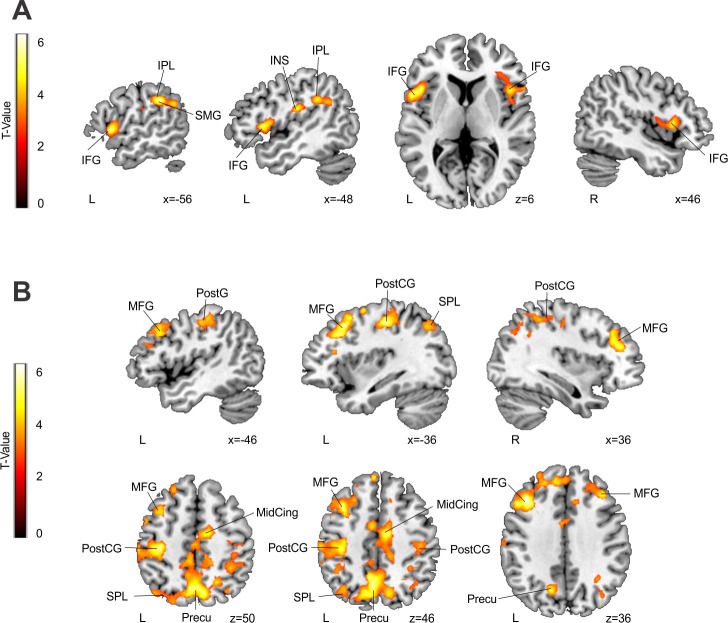
(A) BOLD signal over a ventral frontoparietal network in rule blocks significantly covaries with their corresponding measure of statistical learning (learning slope); the more activity, the greater (that is, more negative) the slope (see also S4 Fig). (B) BOLD signal activity over a dorsal frontoparietal network (rule blocks minus no-rule blocks) covarying with the measure of goal-directed attention (Part 2 rule effect minus Part 1 rule effect); the more activity, the larger the effect. Only significant results (p < 0.05 FWE-corrected at the cluster level, with an additional p < 0.005 at the voxel level and 50 voxels of cluster extent) are shown for both analyses. Neurological convention is used with MNI coordinates shown at the bottom right of each slice. https://identifiers.org/neurovault.collection:8592. BOLD, blood-oxygenation-levelamily-wise error; IFG, inferior frontal gyrus; INS, insula; iPL, inferior parietal lobule; MFG, middle frontal gyrus; MidCing, midcingulum; MNI, Montreal Neurological Institute; PostCG, postcentral gyrus; Precu, precuneus; SMG, supramarginal gyrus; SPL, superior parietal lobe.